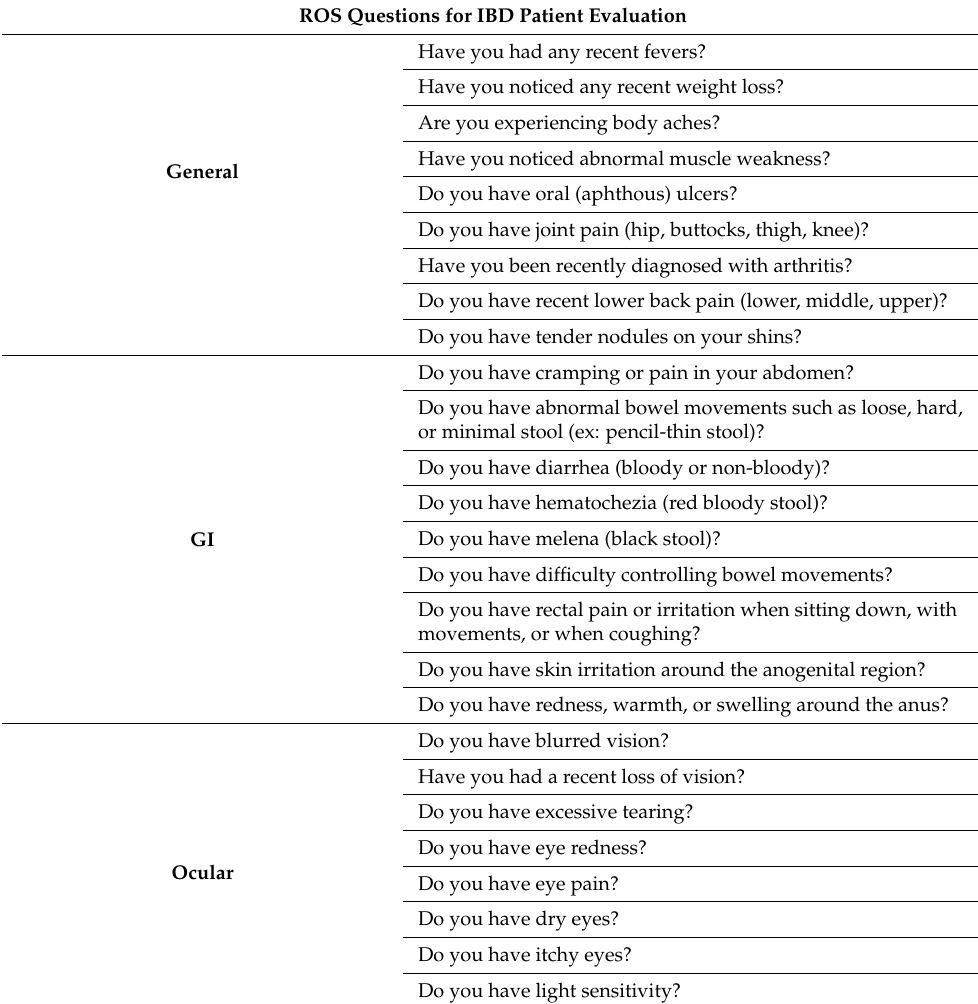
Table 2. Focused ROS questions for IBD patient evaluation. This table details relevant questions regarding symptoms that should be addressed when completing a review of systems for patients with IBD. ROS: review of systems; GI: